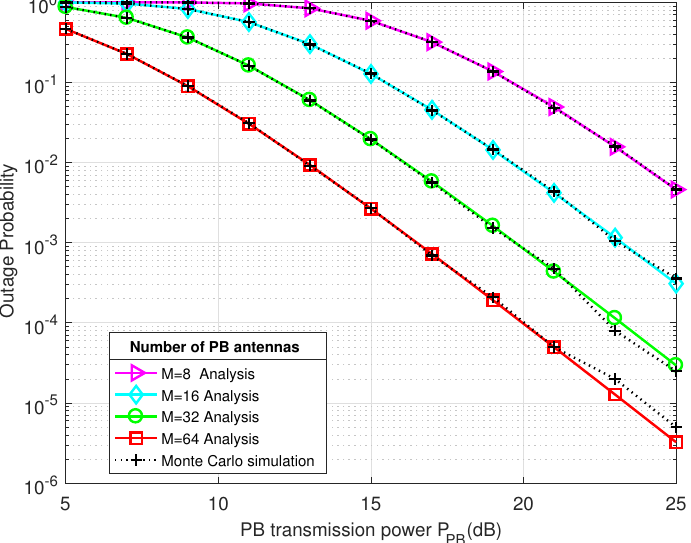
Figure 5. The outage probability of the proposed 2-RRS scheme versus the Power Beacon transmitted power P PB (dB) for different PB antennas number M = { 8, 16, 32, 64 }